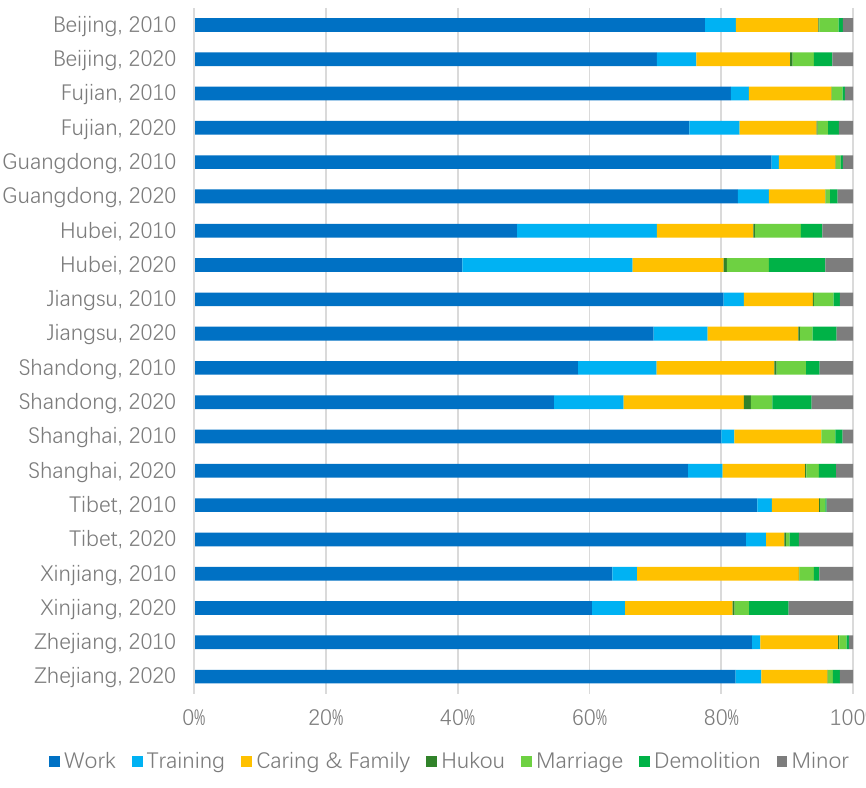
Figure 4. Migration motivation shares in the top ten migration provinces.